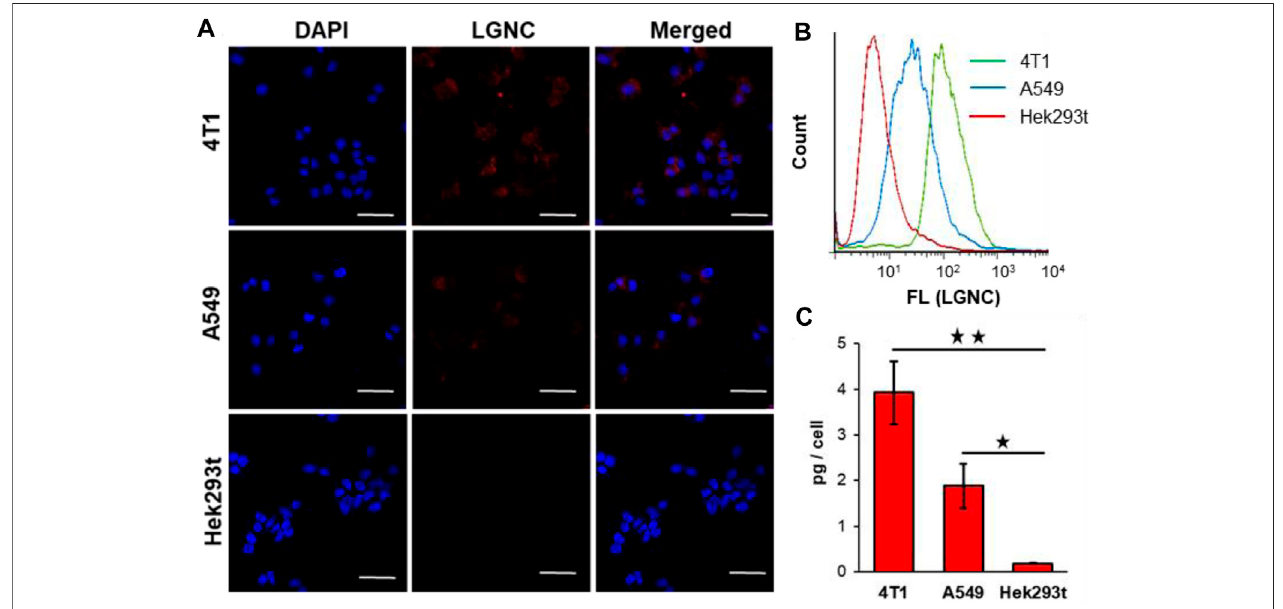
FIGURE4 | Confocal laser scanning microscopy(CLSM) images of4T1, A549,and Hek293t cellsco-incubated with 1.2 μ g/ml LGNCs for 4 h (A) . Flow cytometry (FCM)analysisofcellular uptakeratesofLGNCsafter 4-h treatment (B) . Intracellular Au amounts ofLGNCco-incubated cellsdetermined byinductively coupled plasma massspectrometry(ICP-MS)(mean ± SD, n (cid:1) 3) (C) .Statisticalsigni fi cance: + p -value < 0.05; ++ p -value < 0.01.ThescalebarinCLSMimagesrepresents50 μ m. fi gure5